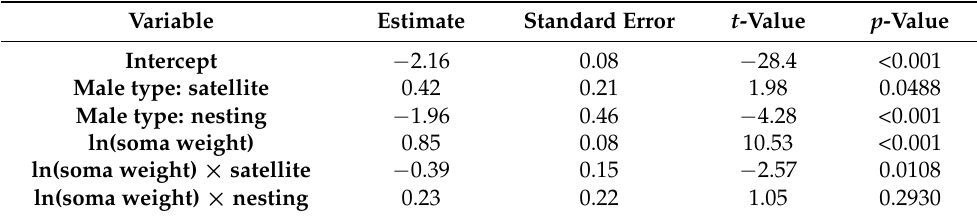
Table 1. The allometric relationship between soma weight and testes weight based on the